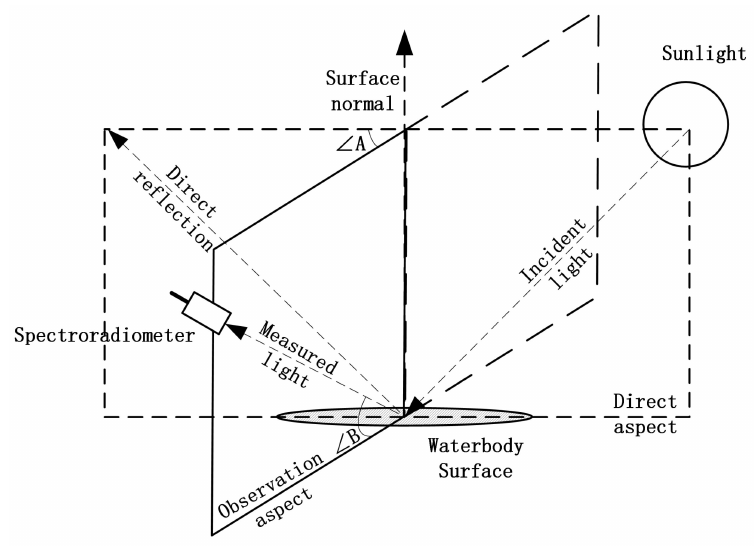
Figure 2. Reflectance data collection using the above-water measurement method. The water samples and the spectral data collected by the ASD FieldSpec 4 were obtained at the same